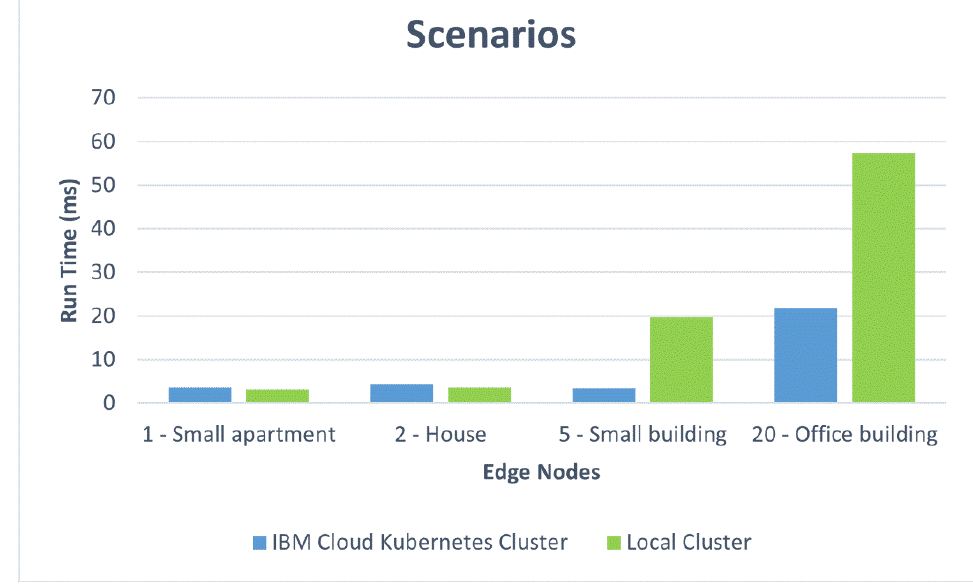
Figure 14. Comparative run times for different scenarios.